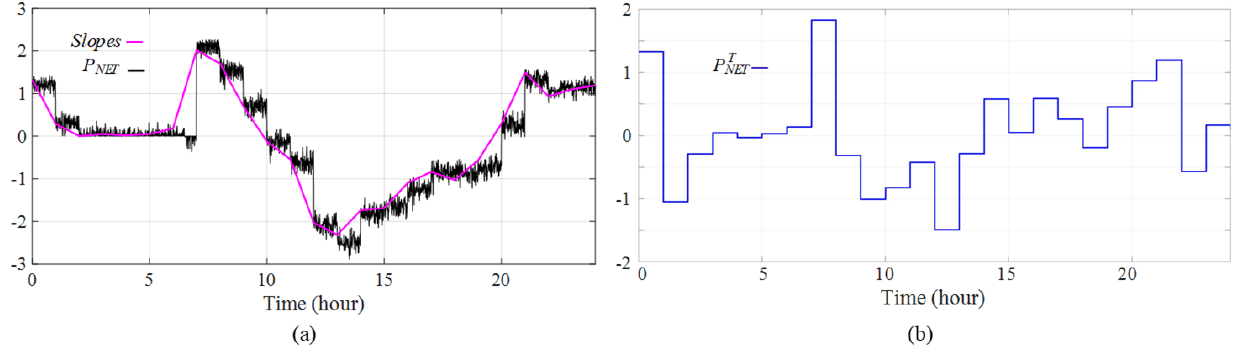
Figure 7. NG net power trend analysis. ( a ) P NET and the slopes coming from two consecutive samples (hourly) and ( b ) P T . NET